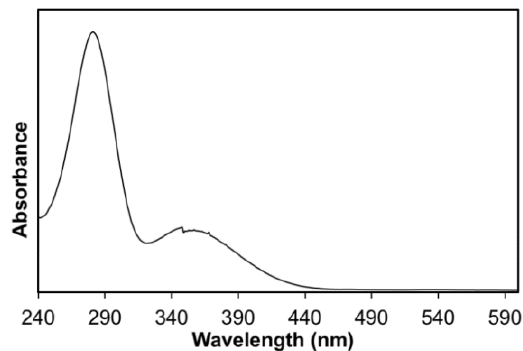
Figure 4. UV−Vis spectra of a 3.0 × 10 −4 M solution of 1 in CH 2 Cl 2 .